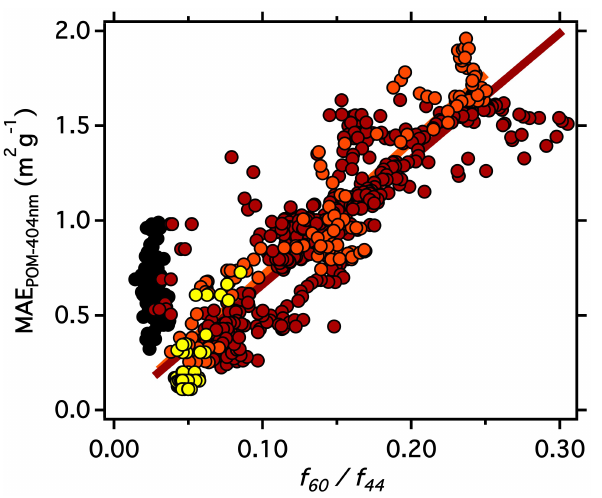
Fig. 4. Mass absorption efficiency (MAE, at 404nm) versus f 60 /f 44 . The color-coding shows the BB plumes sampled (Lack et al., 2012b). Linear fits for red and orange data periods also shown as solid lines (red data: Slope = 6.8 ± 0.1, R 2 = 0.93, orange data: slope = 7.0 ± 0.1, R 2 = 0.93).